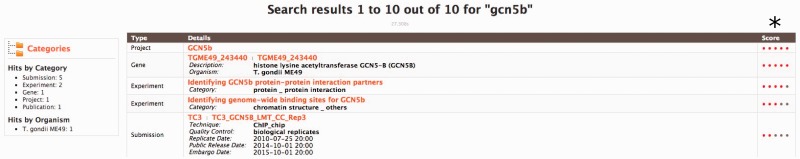
An example of using the ‘Keyword Search’ tool to query toxoMine. We searched toxoMine using the keyword ‘gcn5b’ to find all relevant data objects. The search result shows that a total of 10 data objects contained the search term. (*) The results are sorted based on a score indicative of how closely the keyword correlates to the saved search index.